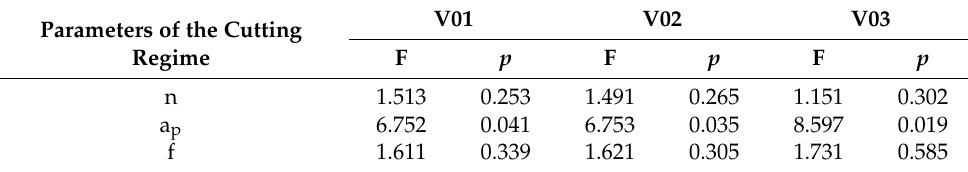
Table 8. Parameters F and p , respectively, after analysis Multiple